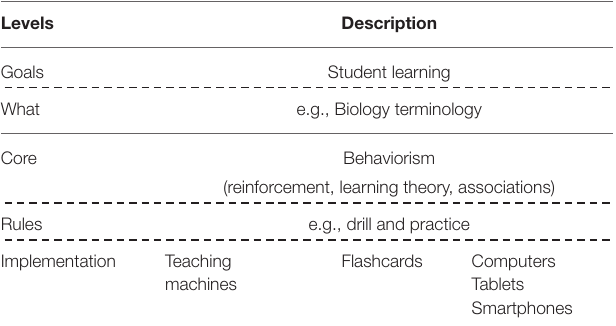
TABLE 1 | Levels for Teaching